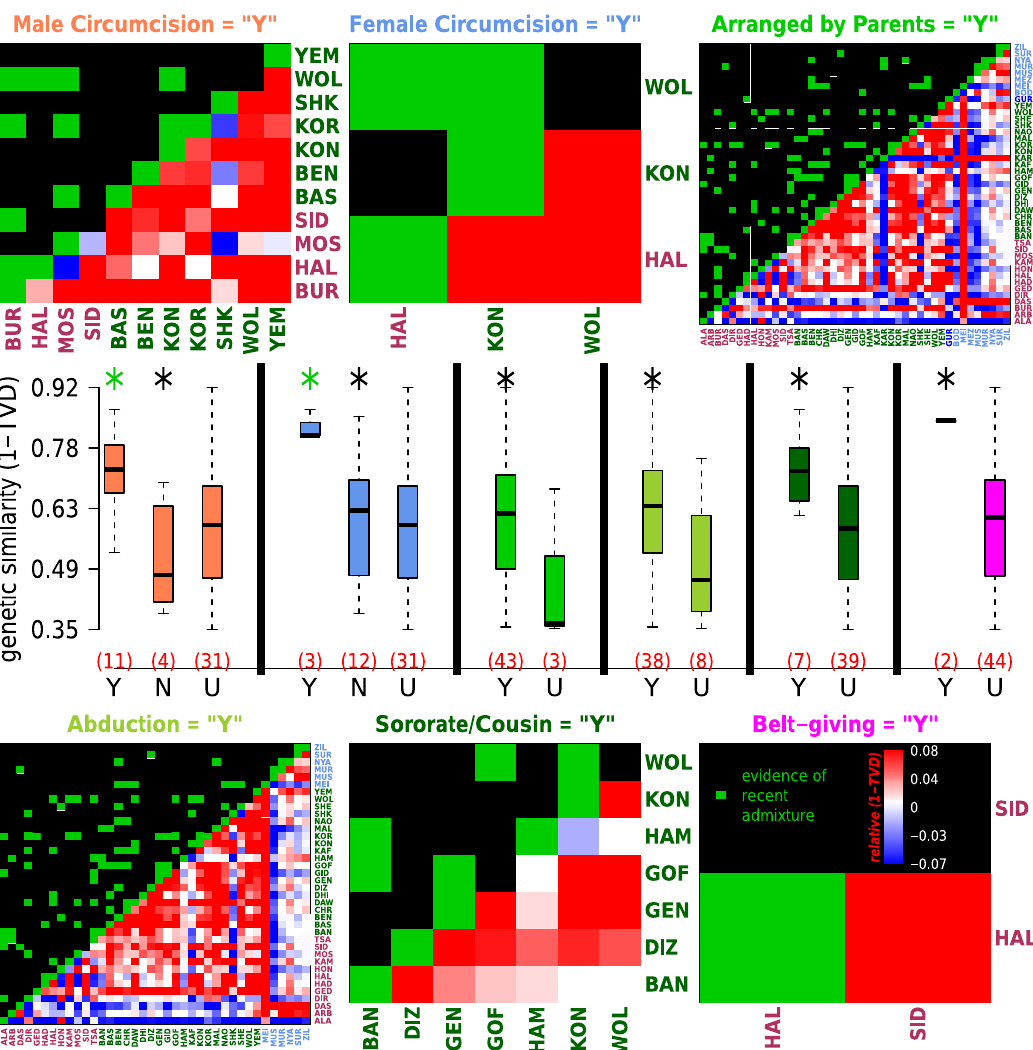
Fig. 5 Sharing of self-declared cultural practices is associated with genetic similarity. Boxplots depict the pairwise genetic similarity (under the “ Ethiopia-internal ” analysis) among ethnic groups that reported practicing ( “ Y ” ), not practicing ( “ N ” ) or gave no information about practicing ( “ U ” ) each of six different cultural traits (labelled above heatmaps, with text colours matching the corresponding boxplots ’ colours). Numbers of groups in each category are in parentheses in red. Each boxplot depicts the median (horizontal black bar), interquartile range (box), minimum and maximum (endpoints) values across pairwise comparisons. Stars above the boxplots denote whether there is a signi fi cant increase (one-sided empirical p val < 0.05, based on re- sampling groups, and without adjusting for multiple comparisons) in genetic similarity among groups in (black) “ Y ” versus “ U ” or (green) “ Y ” versus “ N ” . The bottom right of each heatmap shows the increase (red) or decrease (blue) in average genetic similarity relative to that expected based on the ethnicities ’ language classi fi cations (key in bottom right heatmap), after accounting for the effects of spatial distance, between every pairing of ethnicities who reported practicing ( “ Y ” ) the given trait (axis labels coloured by language group as in Fig. 1a; group labels given in Supplementary Data 1). Green squares in the top left portion of the heatmaps indicate whether > = 1 pairings of individuals from different ethnic groups share atypically long DNA segments relative to all other comparisons of people from the two groups, which is indicative of recent intermixing between the two groups (see Supplementary Note 5); p values provided in Supplementary Table